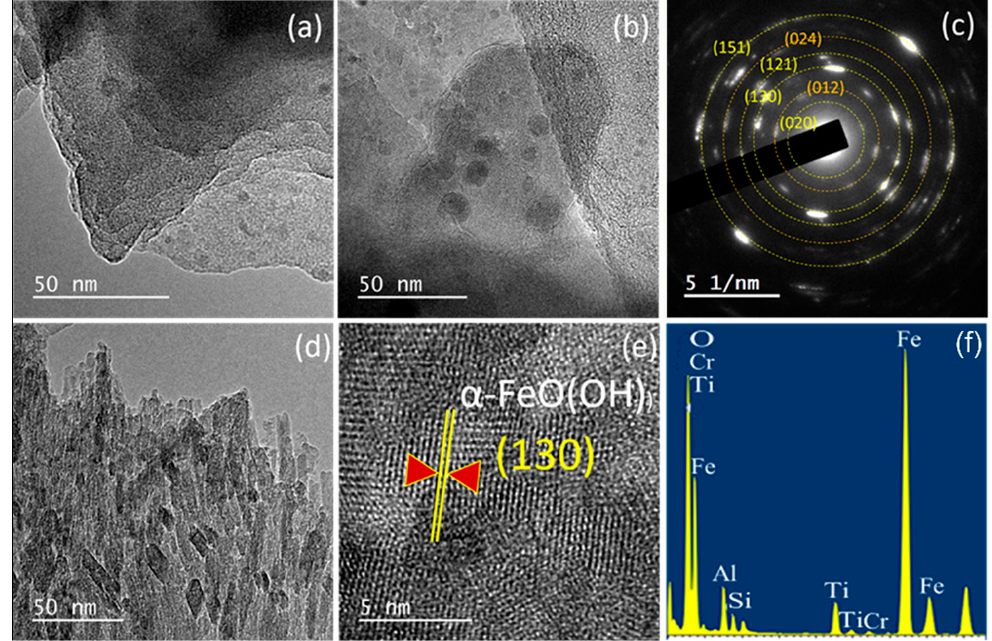
Figure 4. HRTEM micrographs of V2-4M-7D: ( a ) well-layered structures; ( b ) small, rounded iron particles; ( c ) SAED of polycrystalline goethite shown in ( d ); ( e ) magnified view of ( d ) showing d hkl corresponding to goethite ( α -FeO(OH)); ( f ) the spectrum of V2-4M-7D. The specific surface area (S BET ), adsorption capacity (Q m ), total pore volume (V p ), pore size (nm), BET constant (C), and correlation coe ffi cient (R 2 ) values obtained from the adsorption–desorption tests are shown in Table 4. The BET constant (C) values of the investigated untreated and treated samples confirmed that microspores are not present, indicating the validity of the BET